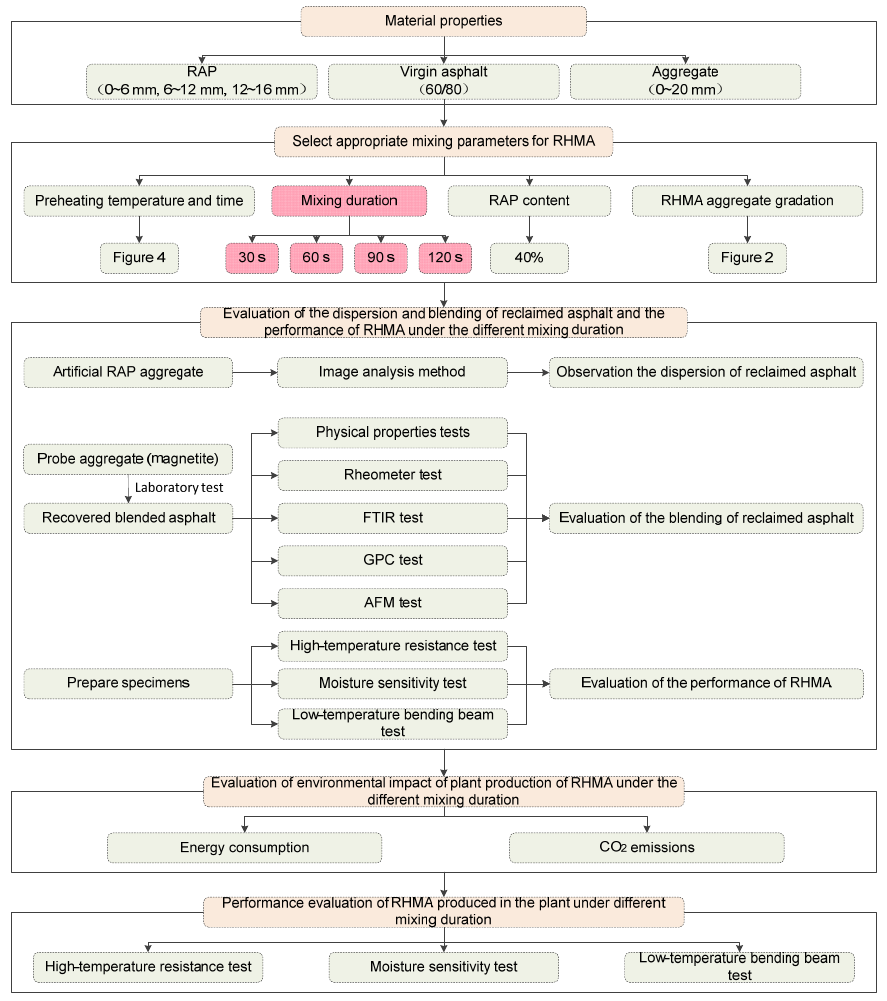
Figure 1. The framework of this study.